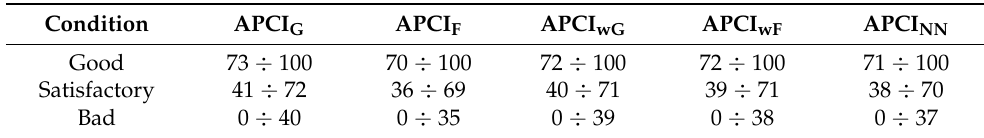
Table 6. Criteria for assessing the technical condition of natural pavements of airfield functional element based on the APCI NN